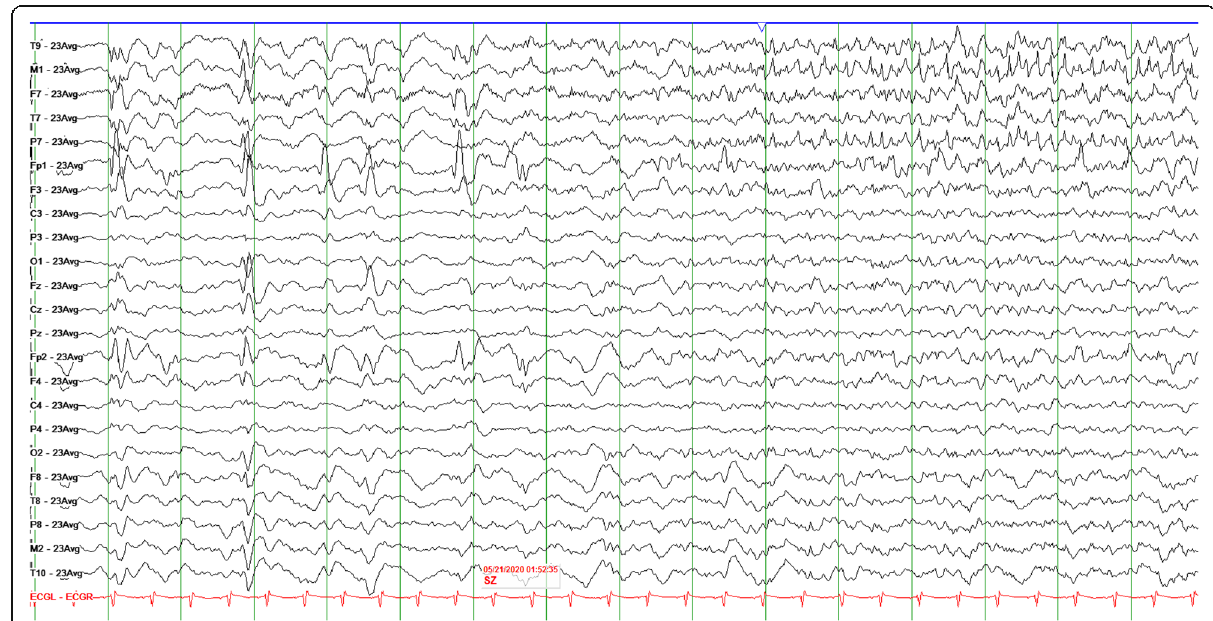
Fig. 5 Lateralized periodic discharges (LPDs) evolving into a seizure in the left frontotemporal region from the same patient as in Figure 1. High pass filter 1 Hz, low pass filter 50 Hz and sensitivity 10